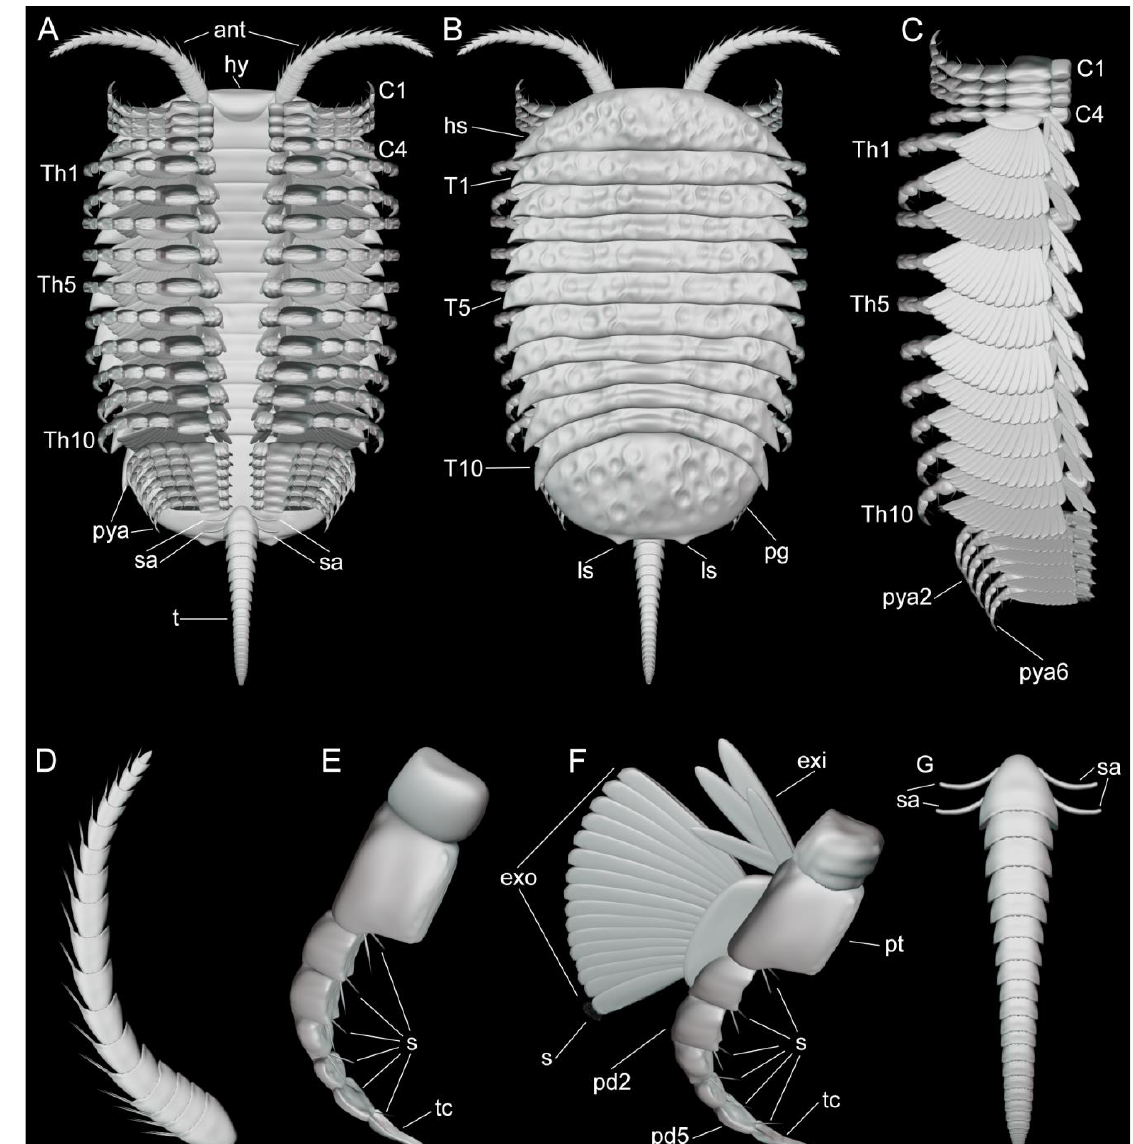
exite on the first pygidial appendage. Note the different directions and positions of the exite (purple) and the exopodite lamellae. Exopodite lobe (el) false-coloured in cyan. ( C ) Dorsal view includes all pygidial appendages from the left side of the animal. Lamellae of each appendage false-coloured differently. Pygidial shield completely removed for clarity. ( D ) Dorsal view of the second left pygidial appendage (pya2 in ( C )) with exopodite lobe (el) false-coloured in red. ( E ) Dorsal view of the fifth left pygidial appendage with exites (exi) with lamellae false coloured in cyan and exopodites (exo) with lamellae false-coloured in green. Other abbreviations: lm—lamellae; sa—specialized accessories. Scale bars: 2 mm in ( A , C ) and 1 mm in ( B , D , E ).